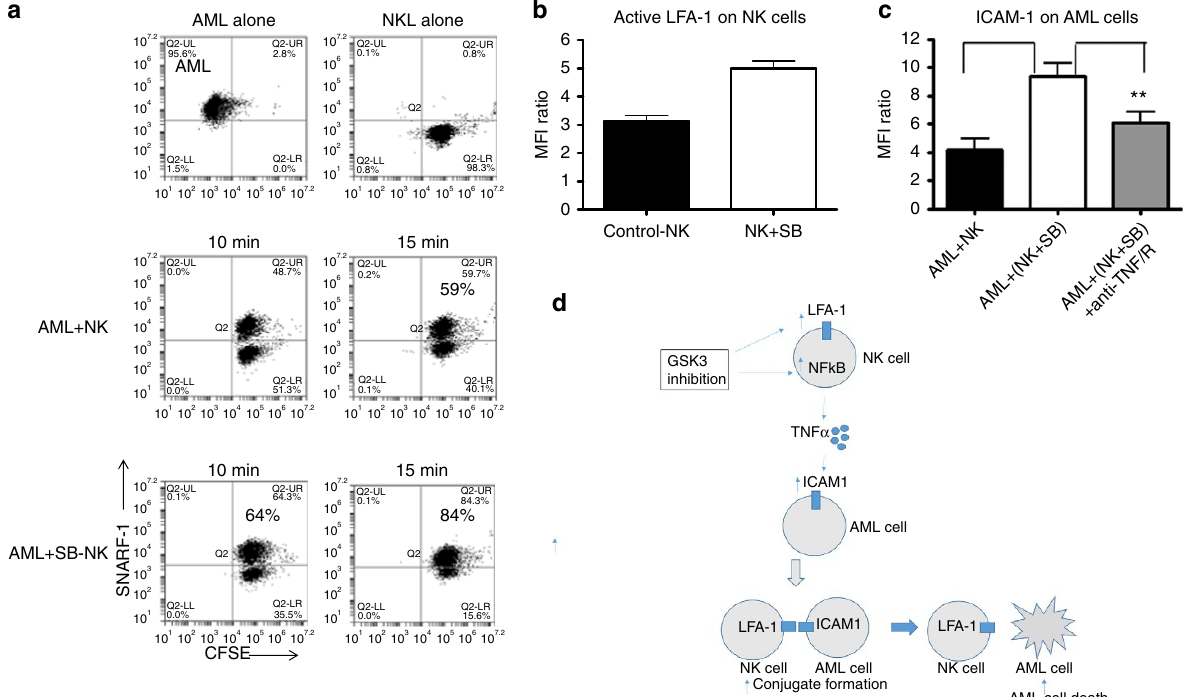
Figure 6 | GSK3 inhibition modulates surface receptors on human NK cells and target cells after co-culture and leads to enhanced conjugate formation. ( a ) Expanded human NK cells labelled with CFSE (treated with either DMSO or SB overnight) were co-incubated with OCI-AML3 cells labelled with SNARF-1 dye. The cells were co-cultured and conjugate formation was analysed using flow cytometry at the indicated times. As a control, isolated populations of NK cells and OCI-AML3 cells were analysed. NK:AML ratio ¼ 2:1. This is a representative study of 3 independent experiments. ( b ) Expanded NK cells were treated with SB or vehicle for 16h and the surface expression of active LFA-1 was assessed by flow cytometry. Data shown are the mean fluorescence intensity (MFI). MFI ratio ¼ MFI LFA-1/MFI Isotype. ( c ) Expanded NK cells were treated with SB or DMSO for 16h and then were co-cultured with OCI-AML3 cells with or without TNF neutralization (TNF-R and TNF antibodies). Data shown are the mean fluorescence intensity (MFI). MFI ratio ¼ MFI ICAM-1/MFI Isotype on gated OC-AML3 cells. (unpaired Student’s t -test *** P o 0.001, ** P o 0.01). ( d ) Model of GSK3 regulation of NK cell activity against AML. Experiment is performed four